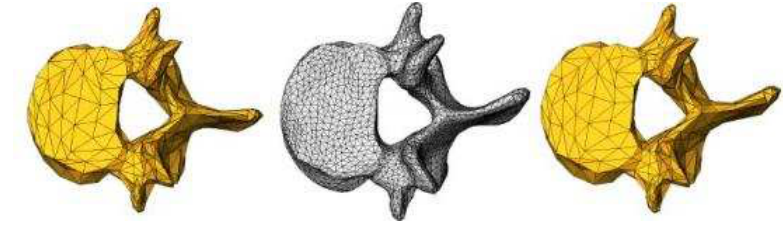
Figure 5. Triangle grid deformation: base vertebra (left side), input vertebra (middle), base grid on geometry of the new objects (right side). The Principal Component Analysis requires the same topology of the FEM mesh (the same number of nodes, matrix connection, etc.) for each of the ob- jects. To achieve this, every new object added to database, must be